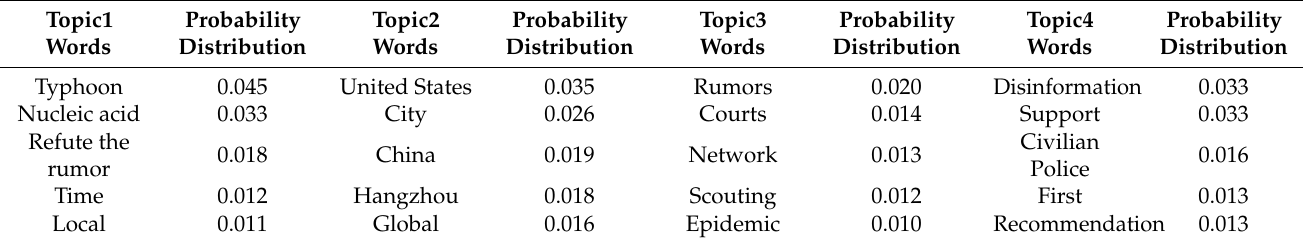
Table 19. C3 LDA theme model